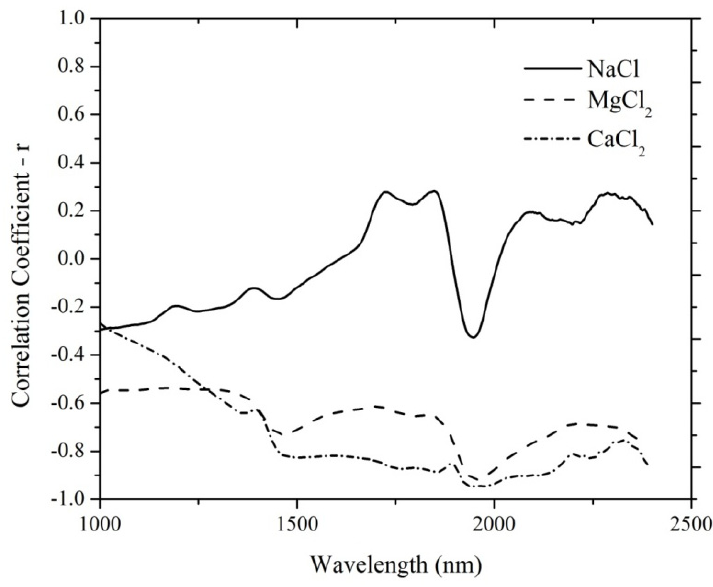
Figure 8. Pearson’s correlation coefficients for the relationship between spectral